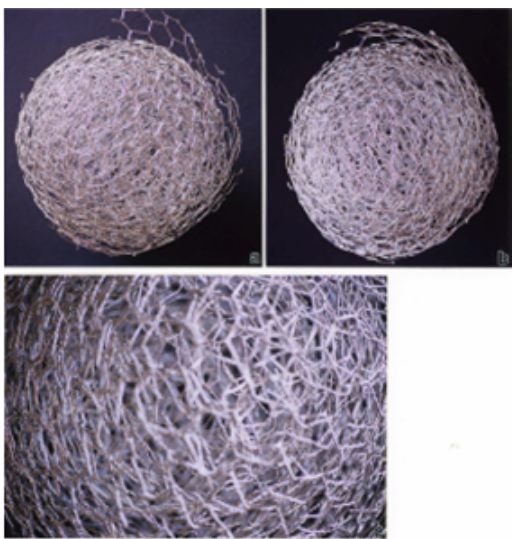
Figure 14: Chicken wire model of carbonaceous spherule formed by overlapping (turbostratic) graphene fragments. (a) and (b) show two views of the spherule. (c) is a magnified view of (b).